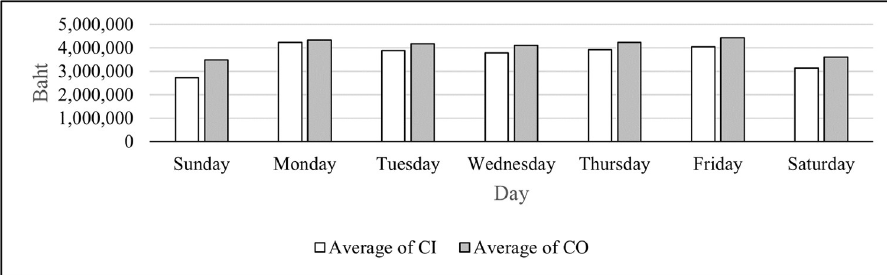
Fig 2. Average CI and CO for branches that open every day.